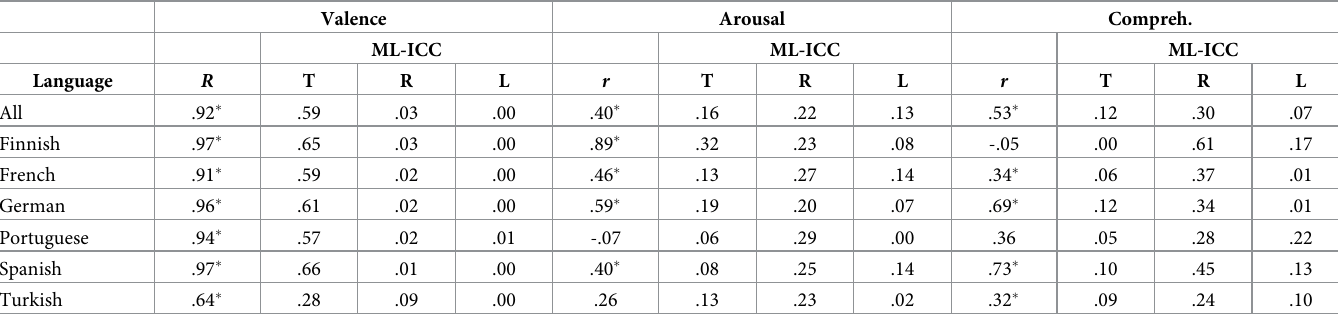
Table 4. Correlations between ratings given to English translations and original texts, and the ML-ICC values for valence, arousal, and comprehensibility. Valence Arousal Compreh.